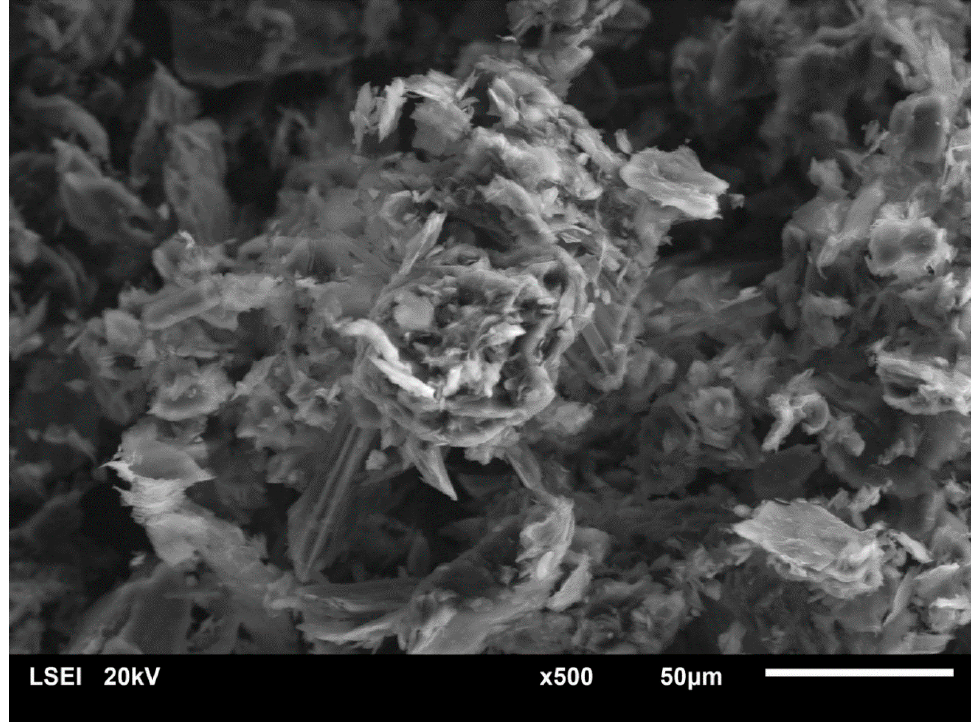
Figure 10. An exemplary SEM photograph depicting the microstructure of developed brush .